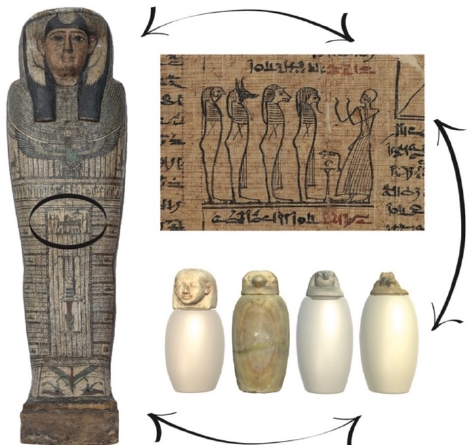
Figure 3. The image shows the different elements of the museum collection, selected for the digital application, which are mutually connected: the physical canopic jars and their representation in the vignette 124 of the Hornefer papyrus and on the decoration of a Tes coffin.